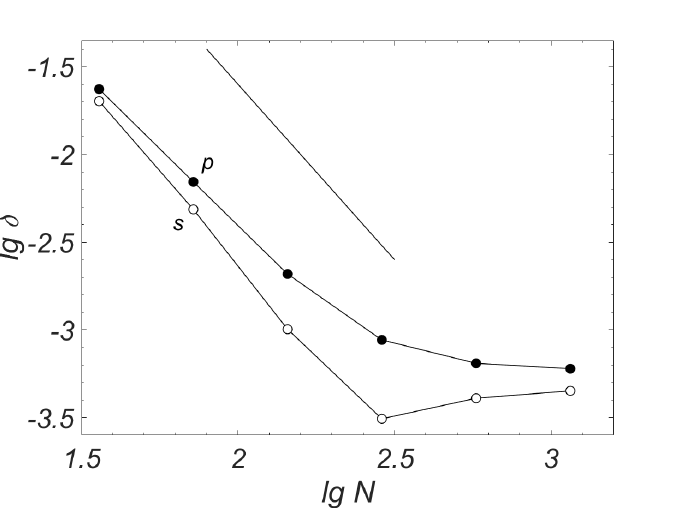
Figure 12. Photonic crystal from Figure 8. Error of calculating the reflection spectrum. The notations correspond to Figure